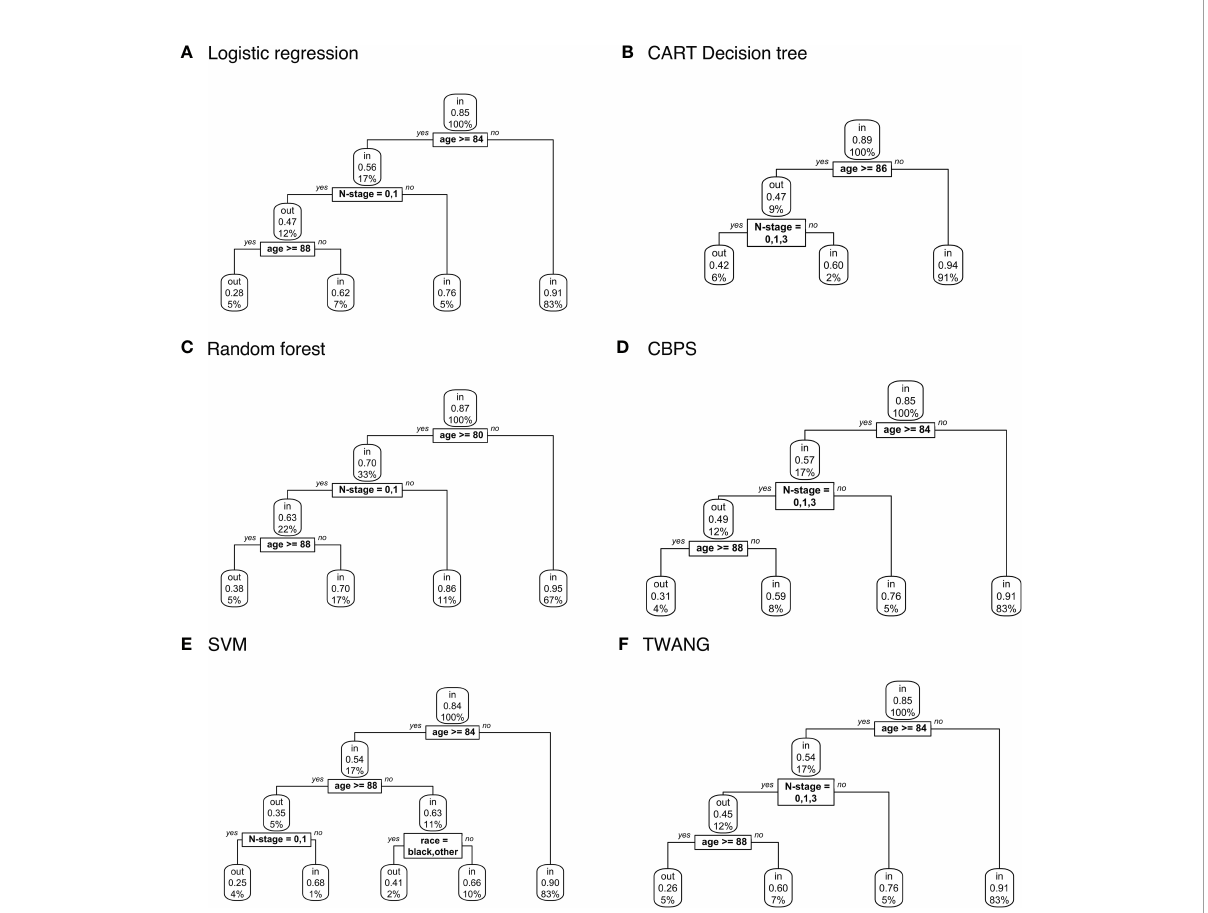
FIGURE 2 Population-level explainer decision trees for head and neck cancer data classify subjects as matched ( “ in ” ) or unmatched ( “ out ” ) given observed features using propensity scores estimated by (A) logistic regression; (B) CART decision tree; (C) random forest; (D) covariate balancing propensity scores; (E) support vector machines; and (F) the Toolkit for Weighting and Analysis of Nonequivalent Groups. Each node lists the probability of the corresponding classi fi cation for the set of features listed above it and the percentage of subjects that exhibit that